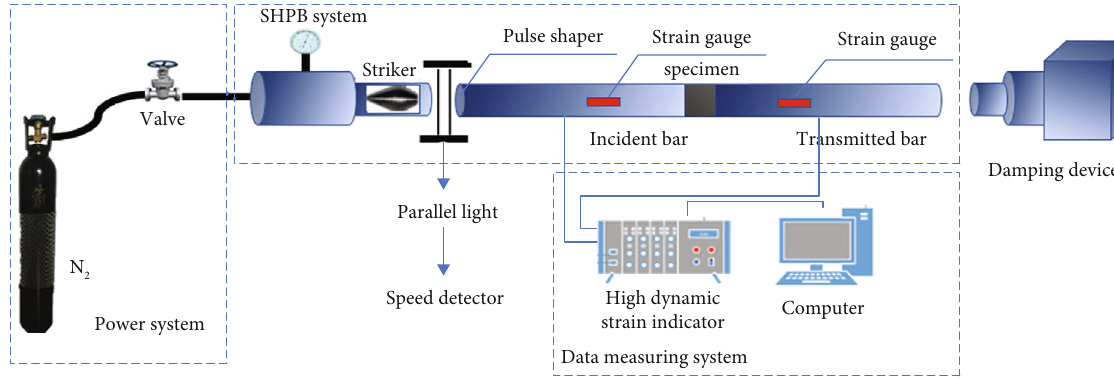
Figure 1: SHPB impact test